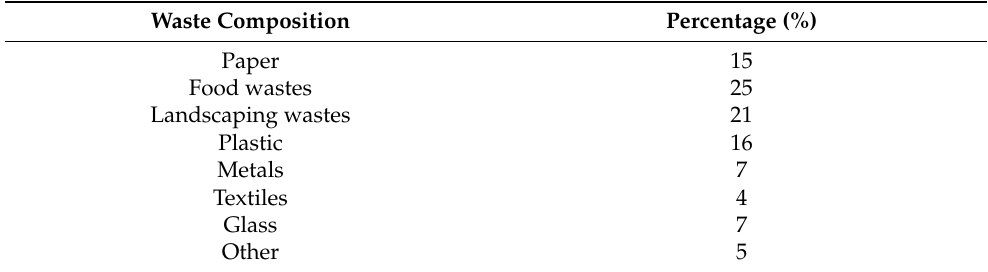
Table 3. Typical composition of municipal solid wastes in Kazakhstan cities, %. Data for table from [62]. Waste